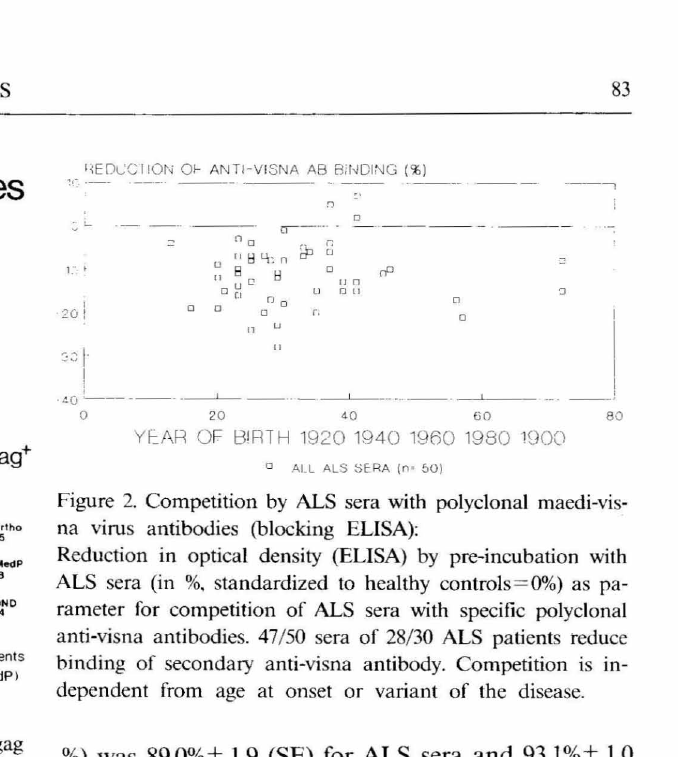
Figure I. Significantly elevated anti HFV-env and/or HFV-gag ELISA and anti HSRV-gag immunoblot antibodies in ALS: Summary of ELISA and immunoblot screening for human foamy virus antibodies in diagnostic subgroups larger than 30 patients; ALS = amyotrophic lateral sclerosis, Park. = Parki nson's syndromes, MedPer= hospital personnel, OND = other neurological diseases as defined (cf. methods), Ortho=ortho pedic patients Ulm 1990-1992. SurgPat= South-West German surgical patients repol1ed earlier (I) and tested in the same laboratory 1989-1991.